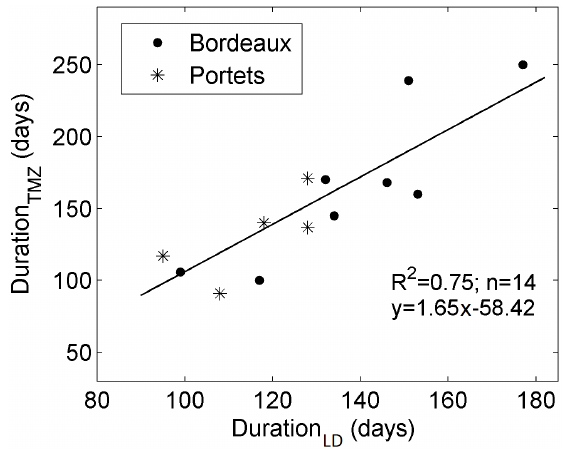
Figure 13. Duration of the TMZ presence as a function of the num- ber of days per year where the river flow was below 250m 3 s − 1 at Bordeaux station and 160m 3 s − 1 at Portets